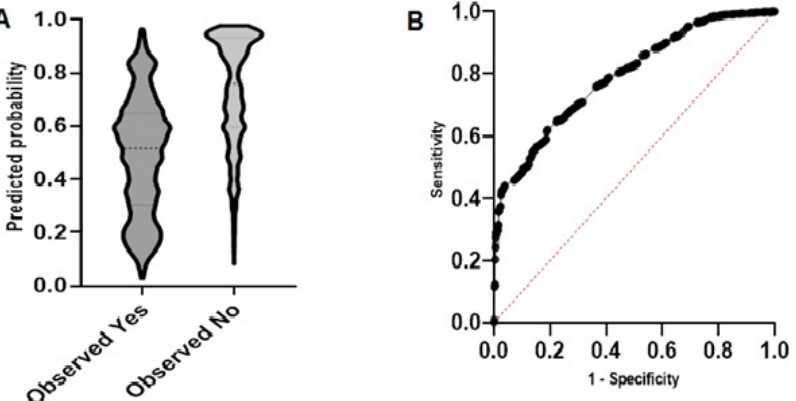
Figure 4. Model diagnosis. ( A ) Predicted probability graph to show how accurate the model was at predicting the outcome of the study. ( B ) The ROC curve shows the ability of the model to correctly classify each cohort of the study (area = 0.81, 95% CI: 0.97–0.81, p <